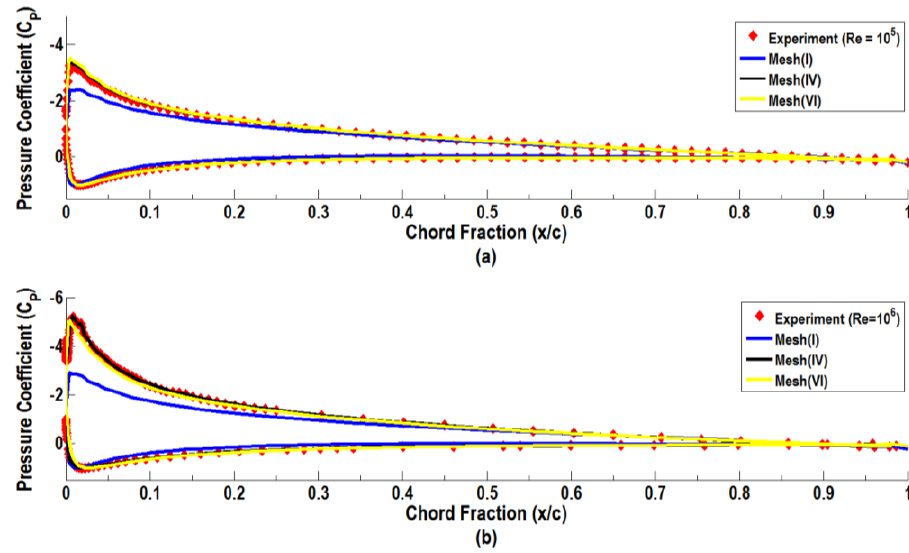
Figure 4. Comparison of pressure coefficient curves along the sides of airfoil from different grids at α = 12° and δ = 0° with the experimental data of Rethmel [27] at ( a ) Re = 10 5 and ( b ) Re = 10 6 .